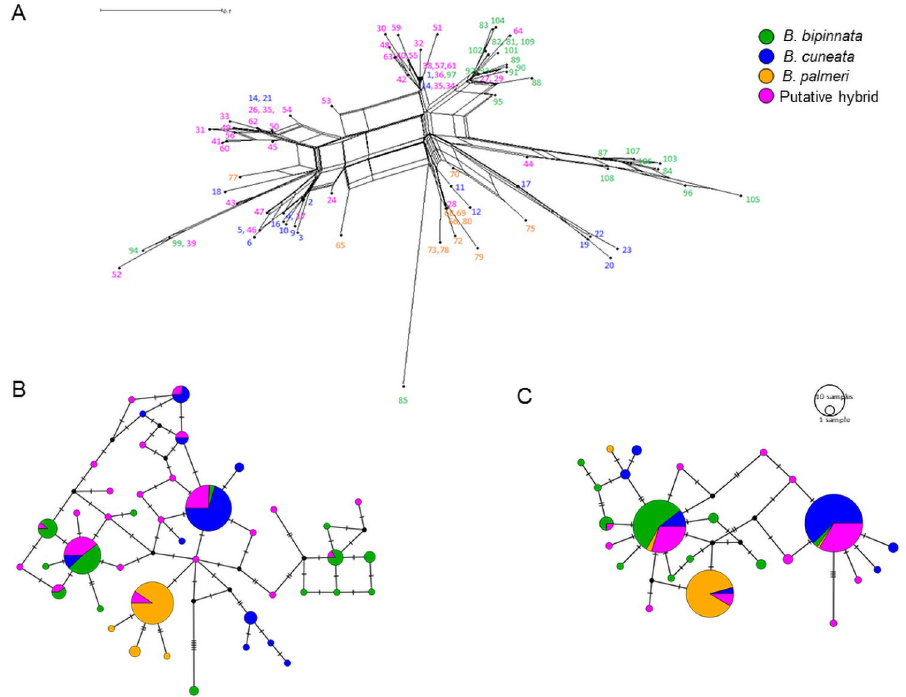
Fig 2. Neighbor-net tree (A) and median-joining haplotype networks for 202 phased sequences of the (B) ETS and (C) PEPC nuclear genes in Bursera bipinnata (green), B . cuneata (blue), B . palmeri (yellow), and putative hybrids (pink). Size of nodes is proportional to the number of sequences per haplotype, dashed lines represent the number of mutational steps separating haplotypes, and black nodes represent unsampled haplotypes.